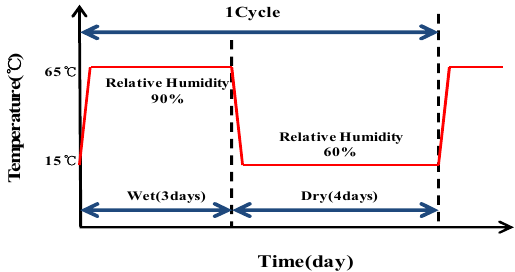
Figure 2. Corrosion acceleration cycle (wet–dry